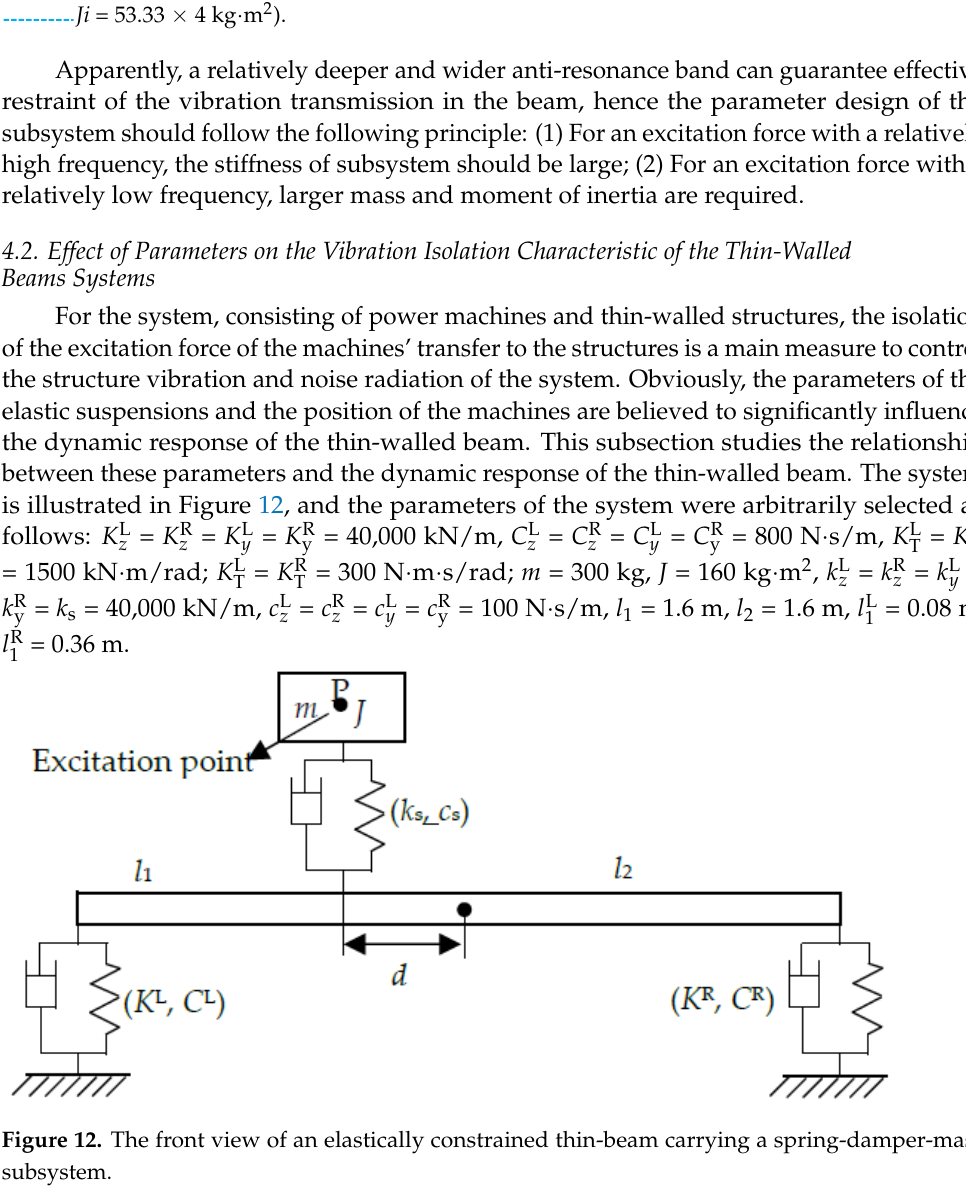
Figure 12. The front view of an elastically constrained thin-beam carrying a spring-damper-mass subsystem.